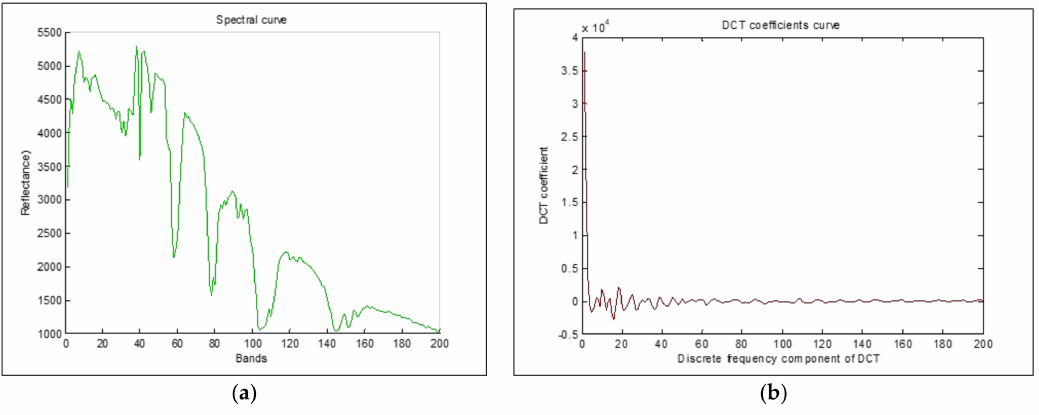
Figure 1. ( a ) Spectral curve, ( b ) DCT Coefficients curve.